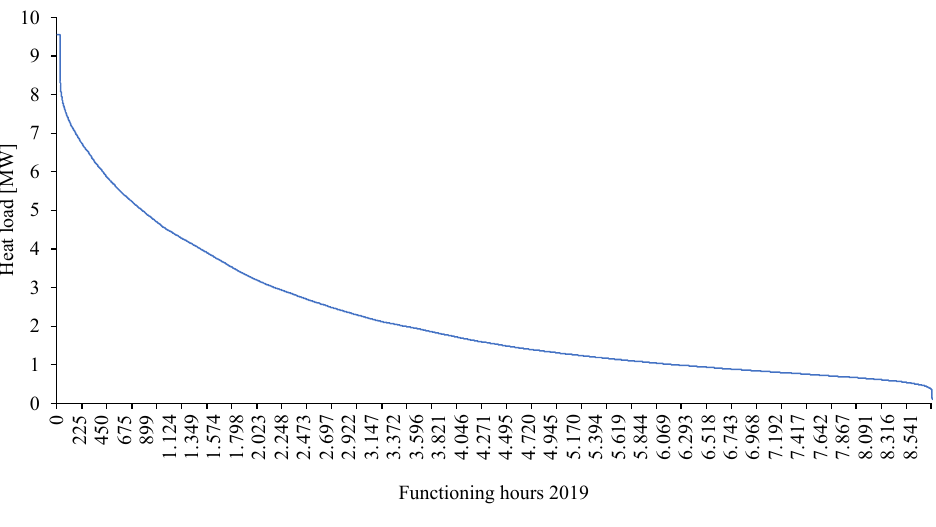
Figure 5. Heat load duration curve (year 2019) provided by the DH.